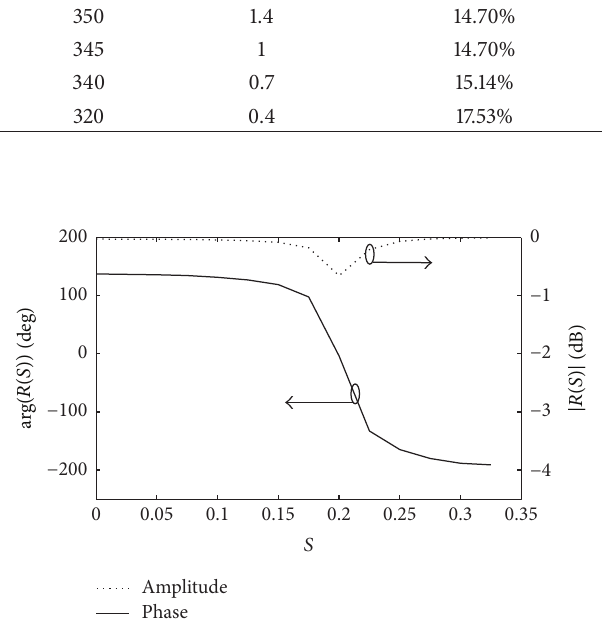
Figure 13: Simulated reflection coefficient versus 𝑆 ( 𝐿 = 7.82 mm, Δ𝑥 × Δ𝑦 = 0.4𝜆